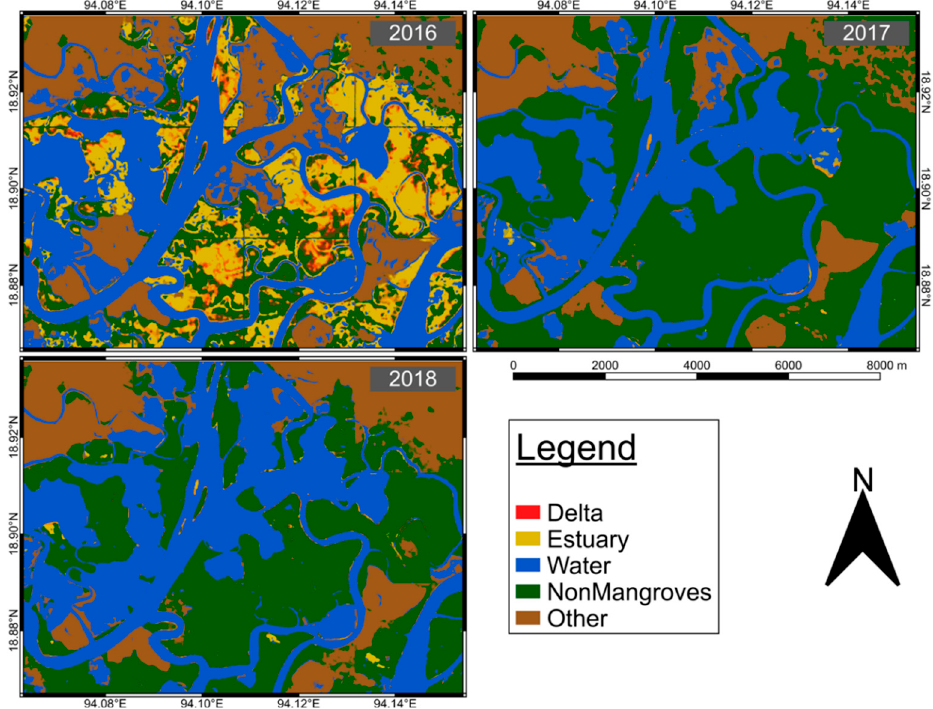
Figure 5. Multi-year classification of the best-performing U-Net model (epoch 6) of a composite of 12 patches of size 256 × 256 pixels of a target area in 2016, 2017, and 2018. The maps only contain five out of seven classes due to the inability of the U-Net model to discern lagoon and open coast classes. The dark green colour of the ‘non-mangroves’ class refers to inland forests. Some areas of overlap between classes may look of different colours from those in the legend. The scalebar and north arrow apply to all images. Table 6. Confusion matrices with relative user and producer accuracies produced using U-Net for the 2016 classified